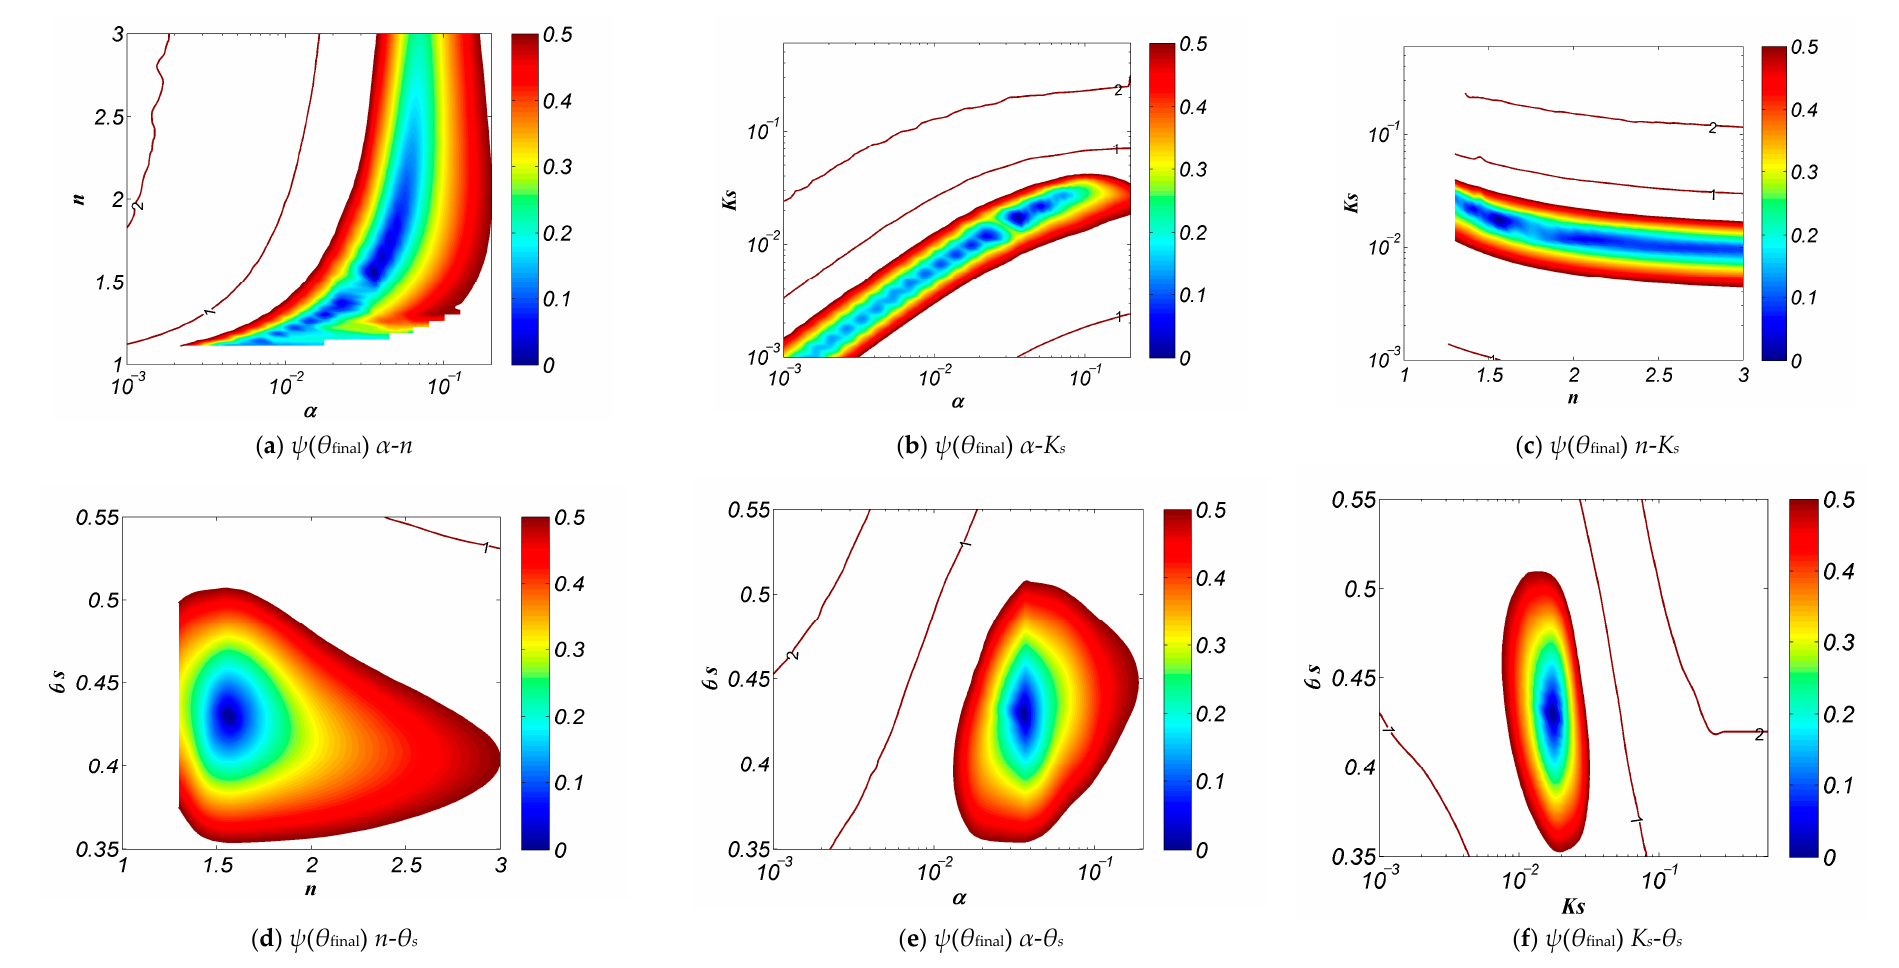
Figure 4. Contours of the objective function ψ ( θ final ) of loam with θ initial as 40% effective saturation. The hydraulic parameters of loam: K s = 0.0173 cm·min − 1 ; n